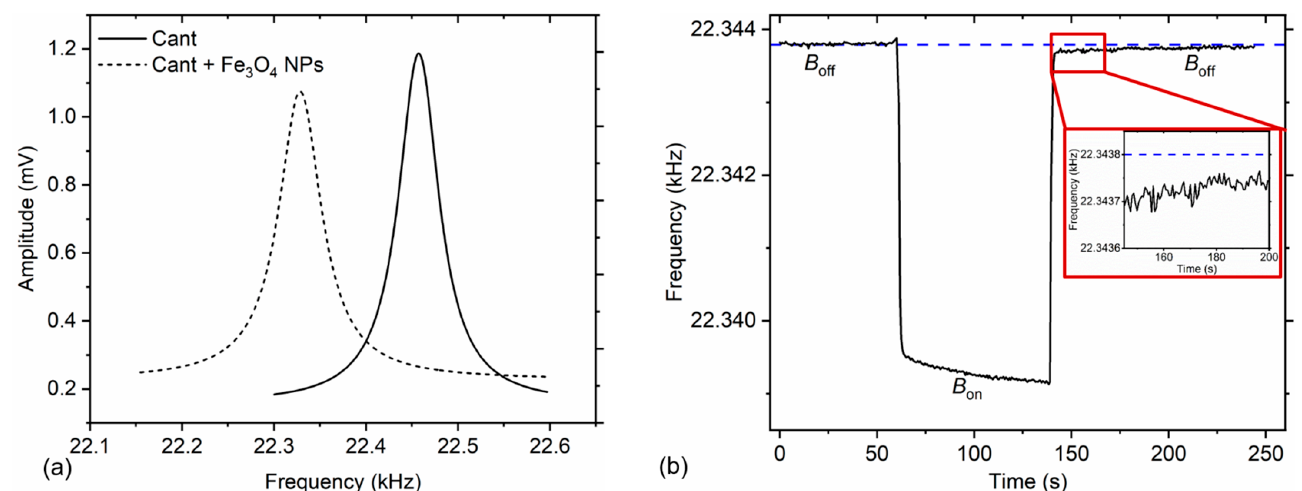
Figure 8. ( a ) Frequency shift response of a cantilever sensor (S88/CAN15-3-2, f 0 = 22.46 kHz) containing 11.1 ± 0.7 ng of 250 nm-sized iron oxide particles. Here, the baseline differences between a blank and particle-laden cantilever was supposedly due to variance in ambient temperature. ( b ) Observed frequency time response under PLL condition after exposure to external magnetic field gradient, in an on-state ( B on ) and off-state ( B off ). In this case, a pair of two permanent magnets was placed 2 mm apart in a face-to-face arrangement as shown in Figure 6. The visible further decrease in f 0 in the B on state was assigned to a temperature rise by induced currents in the cantilever metallization. After switching-off the field, temperature and; consequently, f 0 tended to level out to the initial condition at B off (marked by the horizontal blue dashed line, see inset).